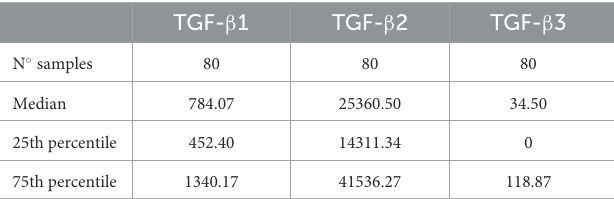
TABLE 1 Concentrations (pg/mL) of transforming growth factor beta (TGF- β ) isoforms ( β -1, - β 2, and - β 3) in seminal plasma samples from